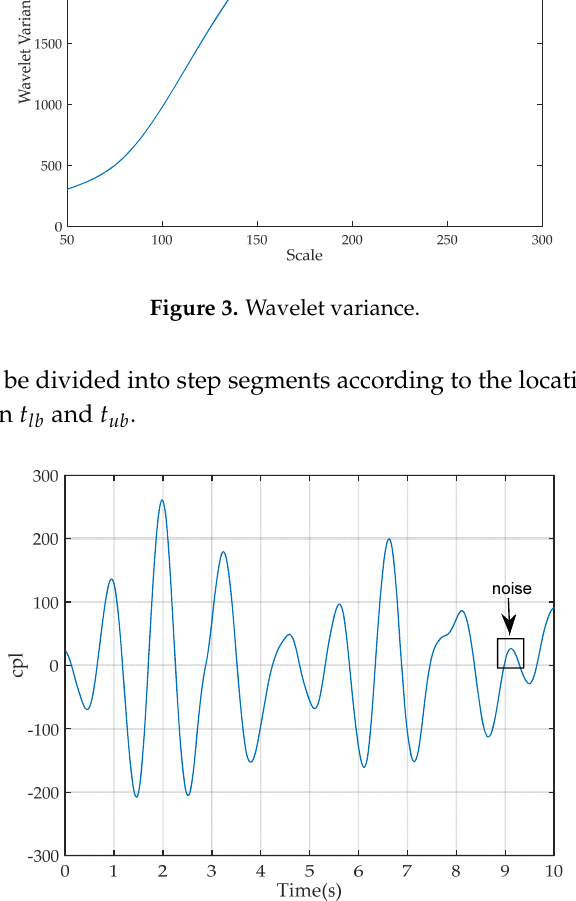
Figure 4. Wavelet coefficient waveform of steps.